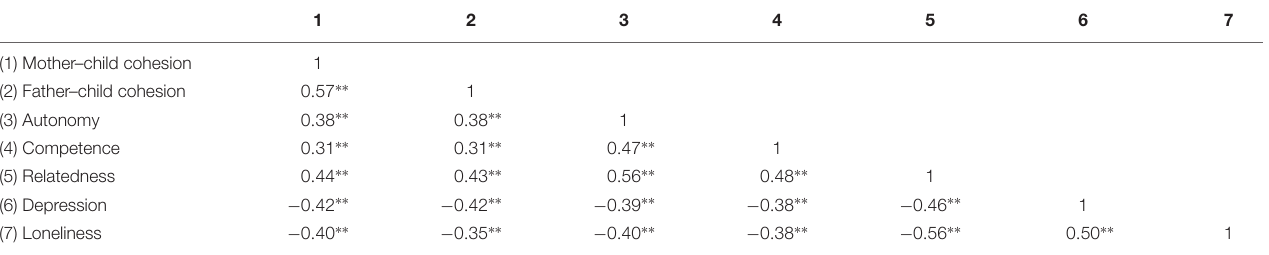
TABLE 2 | Correlations between study variables for left-behind children ( n =